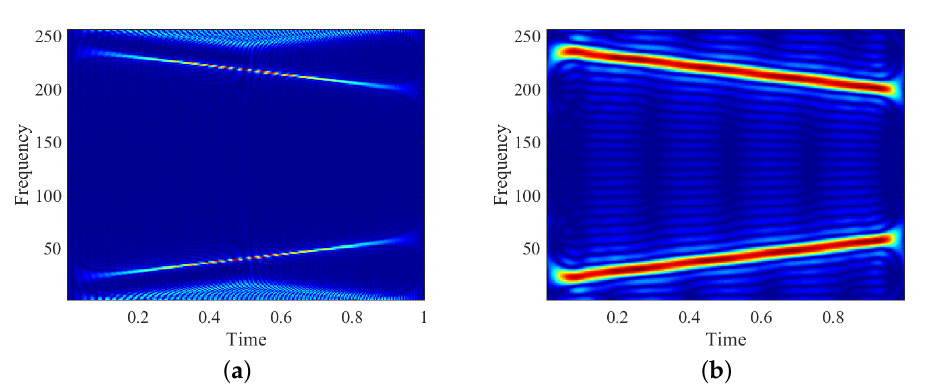
Figure 5. WVD of LFM signal ( a ) WVD of original signal. ( b ) WVD of signal reconstructed by